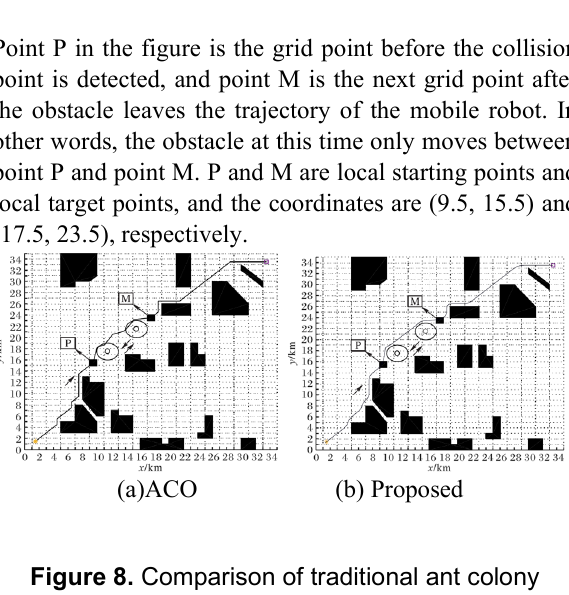
Figure 8. Comparison of traditional ant colony algorithm and the proposed algorithm under dynamic environment